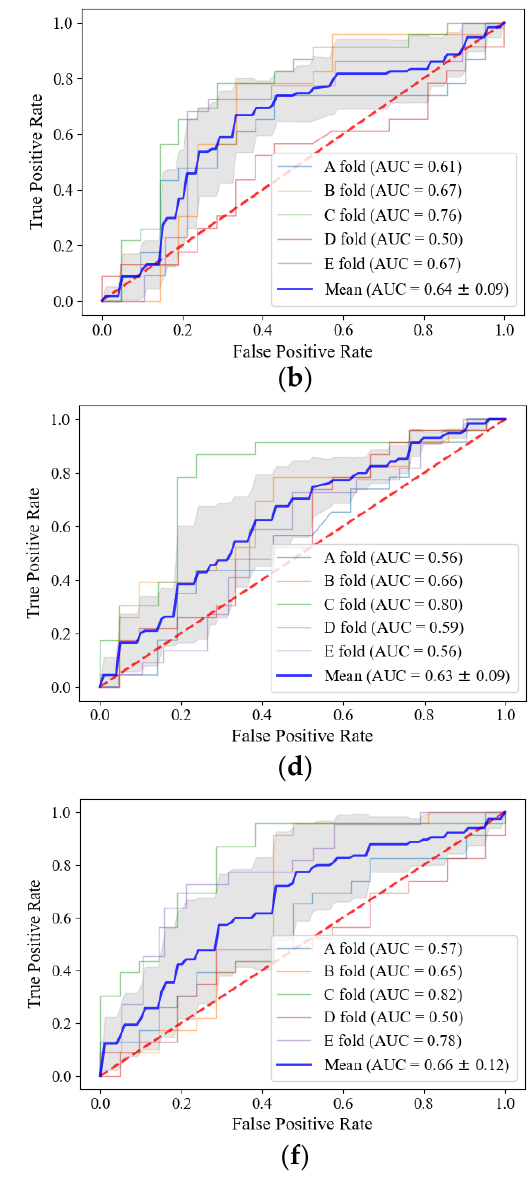
Figure 5. ROC curves for each classifier. The blue line curve indicates the mean value of the 5-fold cross-validation results, and the gray band indicates the AUC variance of the 5-fold cross-validation: ( a ) T and N-stages; ( b ) Intratumoral radiomic classifier; ( c ) Peritumoral 3 mm radiomic classifier; ( d ) Peritumoral 12 mm radiomic classifier; ( e ) Combined 6 mm radiomic classifier; and ( f ) Combined 9 mm radiomic classifiers.